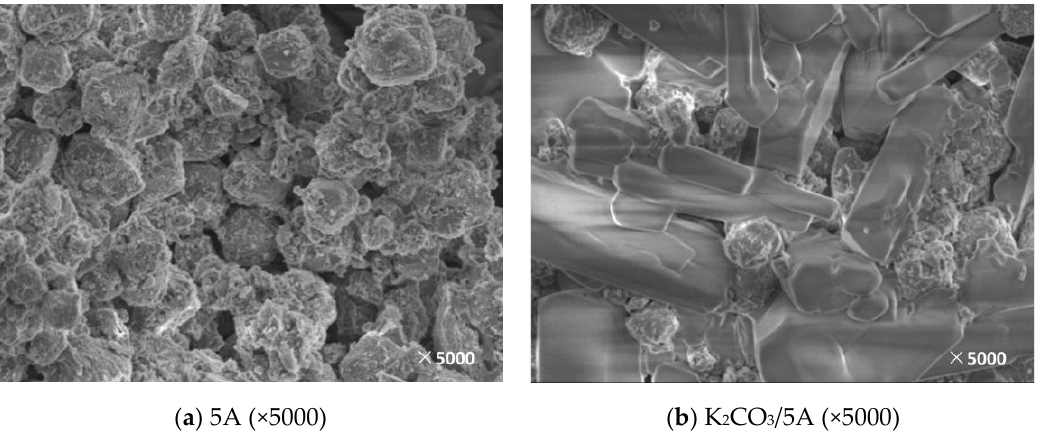
Figure 6. SEM image before and after 5A loading. ( a ): The SEM image of 5A; ( b ): The SEM image of K 2 CO 3 /5A.